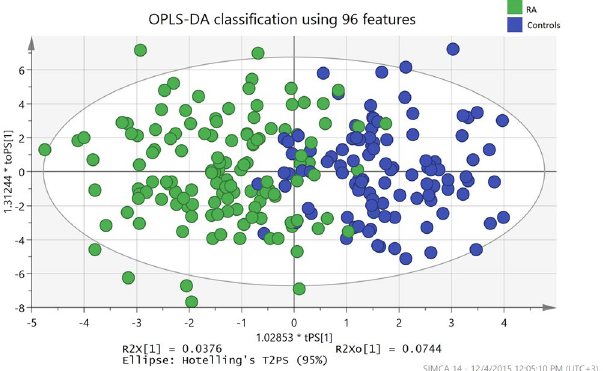
Figure 1. OPLS-DA prediction analysis results using 96 features (metabolites and covariates), sensitivity is 91.6% and specificity is